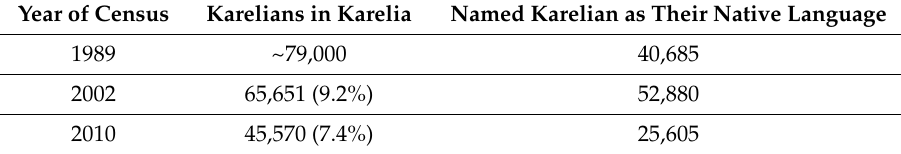
Table 1. Karelians and Karelian speaker population according to the census. The numbers are compiled from